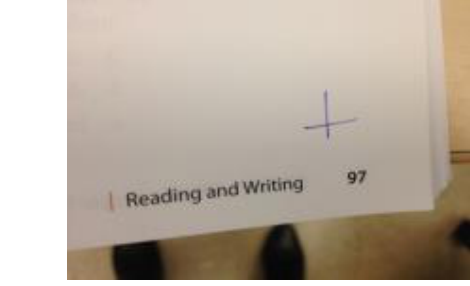
Fig. 6. Excerpt 2, line 25-26